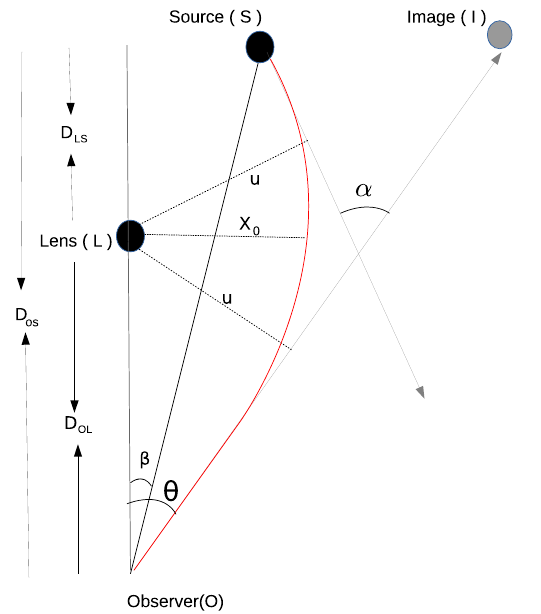
Fig. 4 Schematic for geometrical configuration of gravitational lens- ing